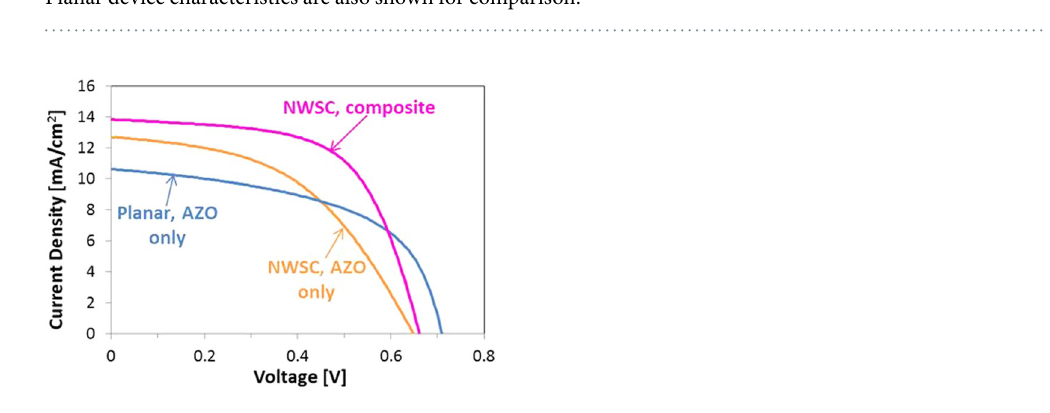
Figure 5. I-V characteristics obtained from ( a ) planar cells, ( b ) NWSC devices with only AZO top contacts, and ( c ) NWSC device with AZO/Ag NW composite top contacts. All devices were fabricated on glass substrates.